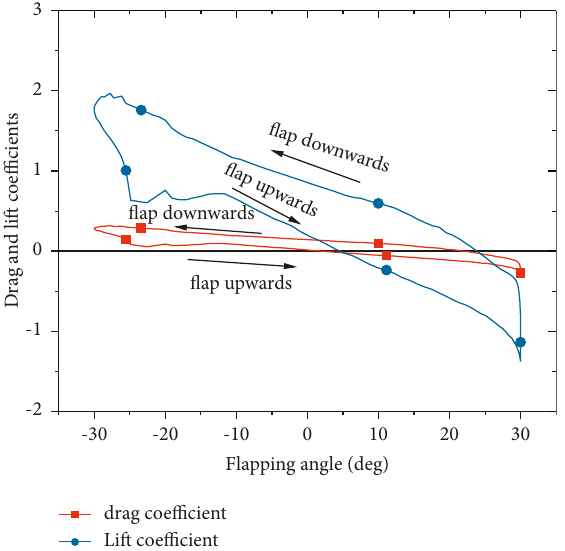
Figure 7: Lift and drag coefficient curves of the bird-like flapping wing